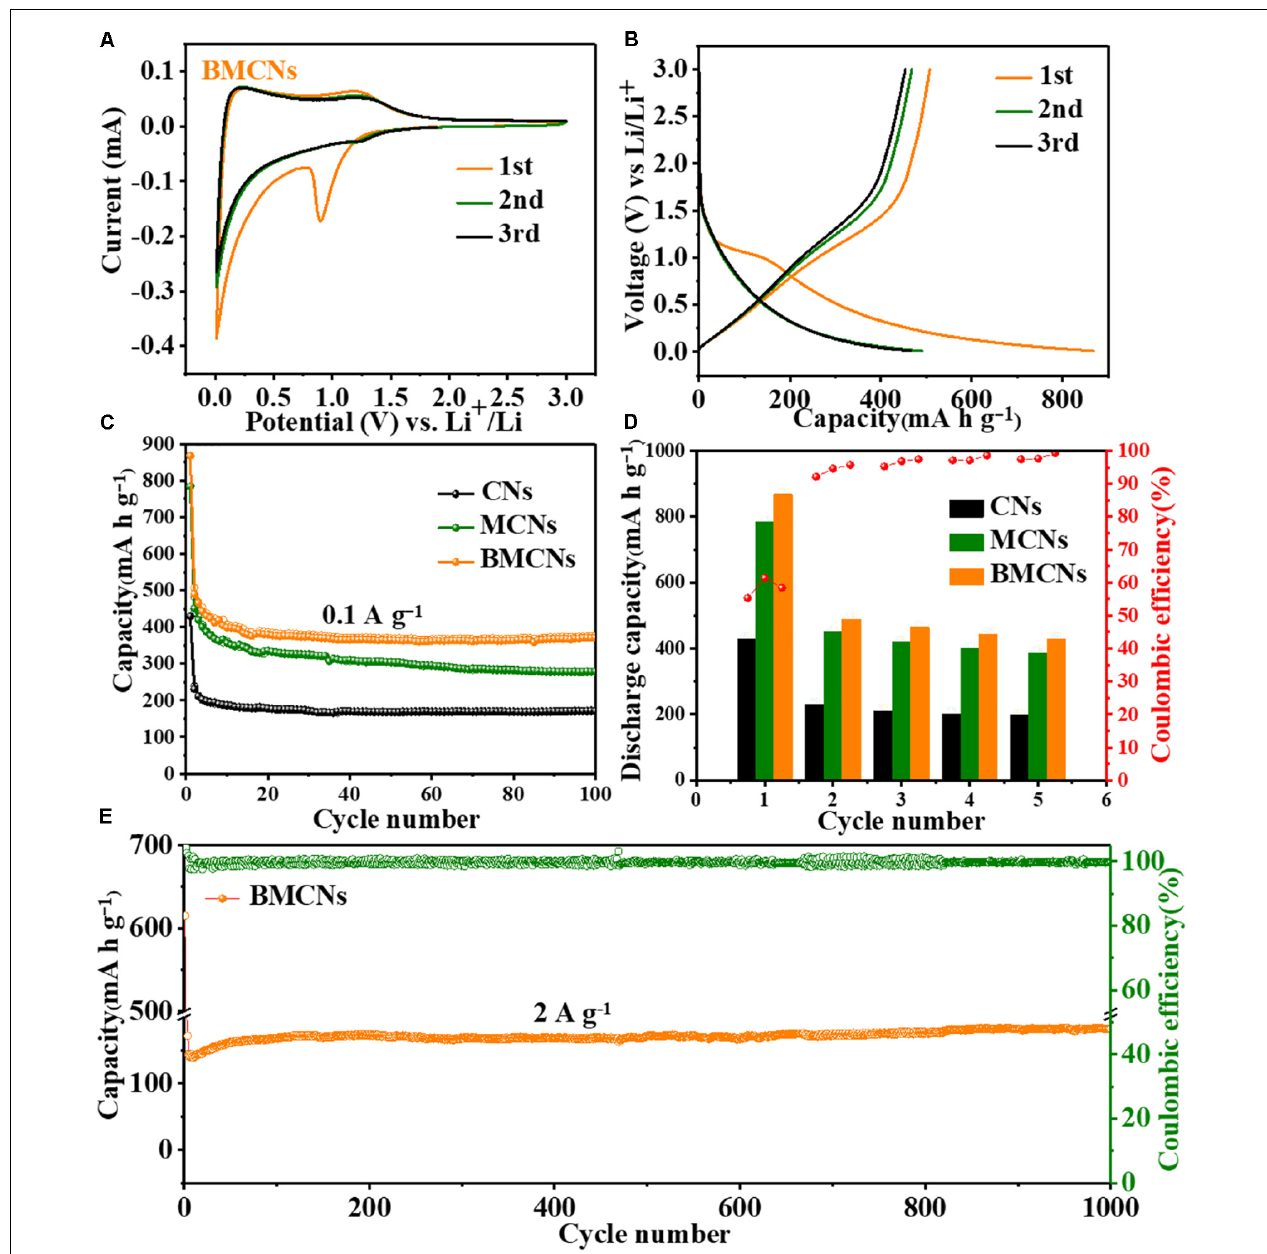
FIGURE 3 | (A) CV curves of the BMCN electrode at a voltage range of 0.01–3.0 V. (B) Charge/discharge curves of the BMCN electrode at a current density of 0.1 A g − 1 . (C) Cycling performance test of CN, MCN, and BMCN electrodes at the current density of 0.1 A g − 1 . (D) Discharge capacity and Coulombic efficiency